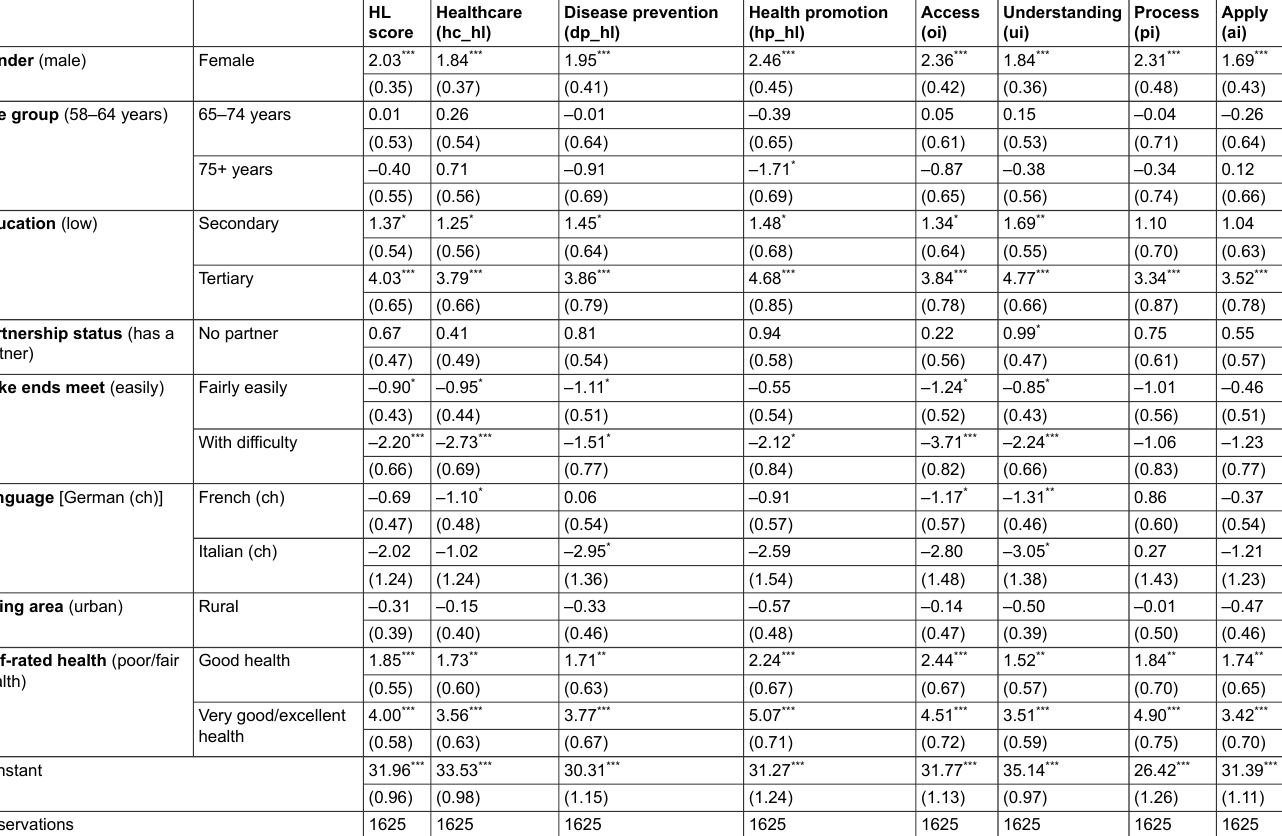
Table 4: Partial associations of standardised health literacy score and sub-indices with respondents’ sociodemographic characteristics, adults aged 58+, SHARE Switzerland, 2019/ 2020, n = 1,625